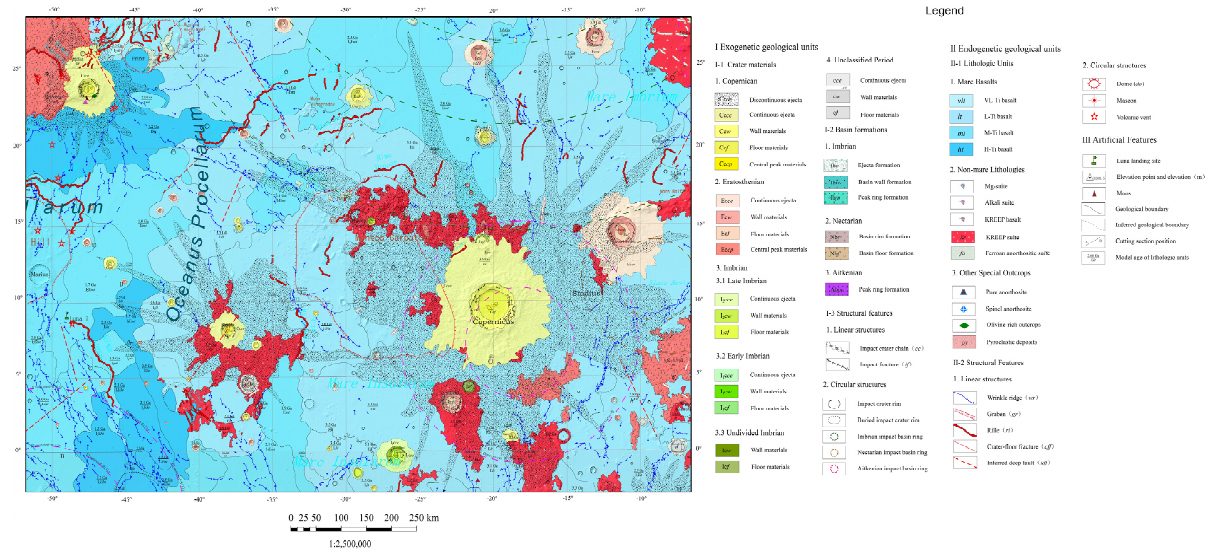
Figure 12. A 1:2,500,000 geological map [66] of the study area.